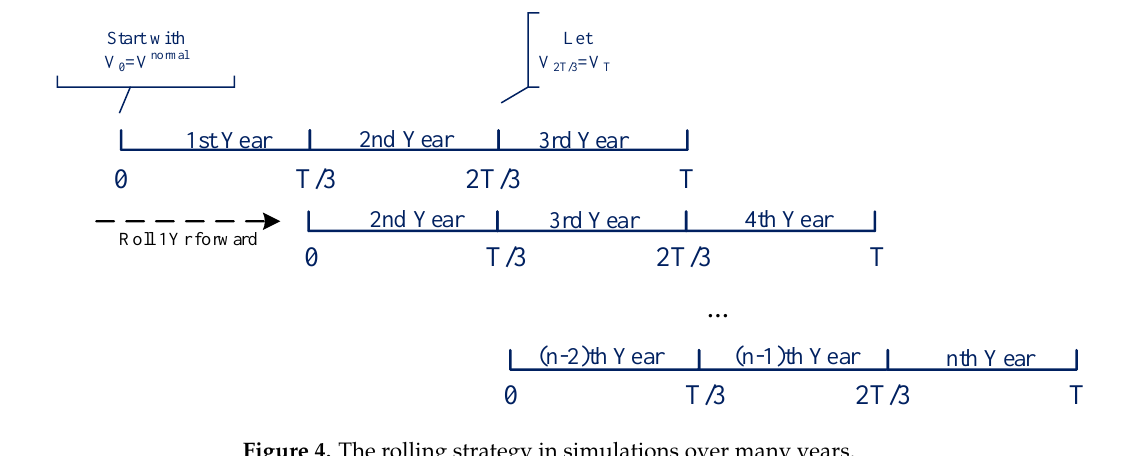
Figure 4. The rolling strategy in simulations over many years.